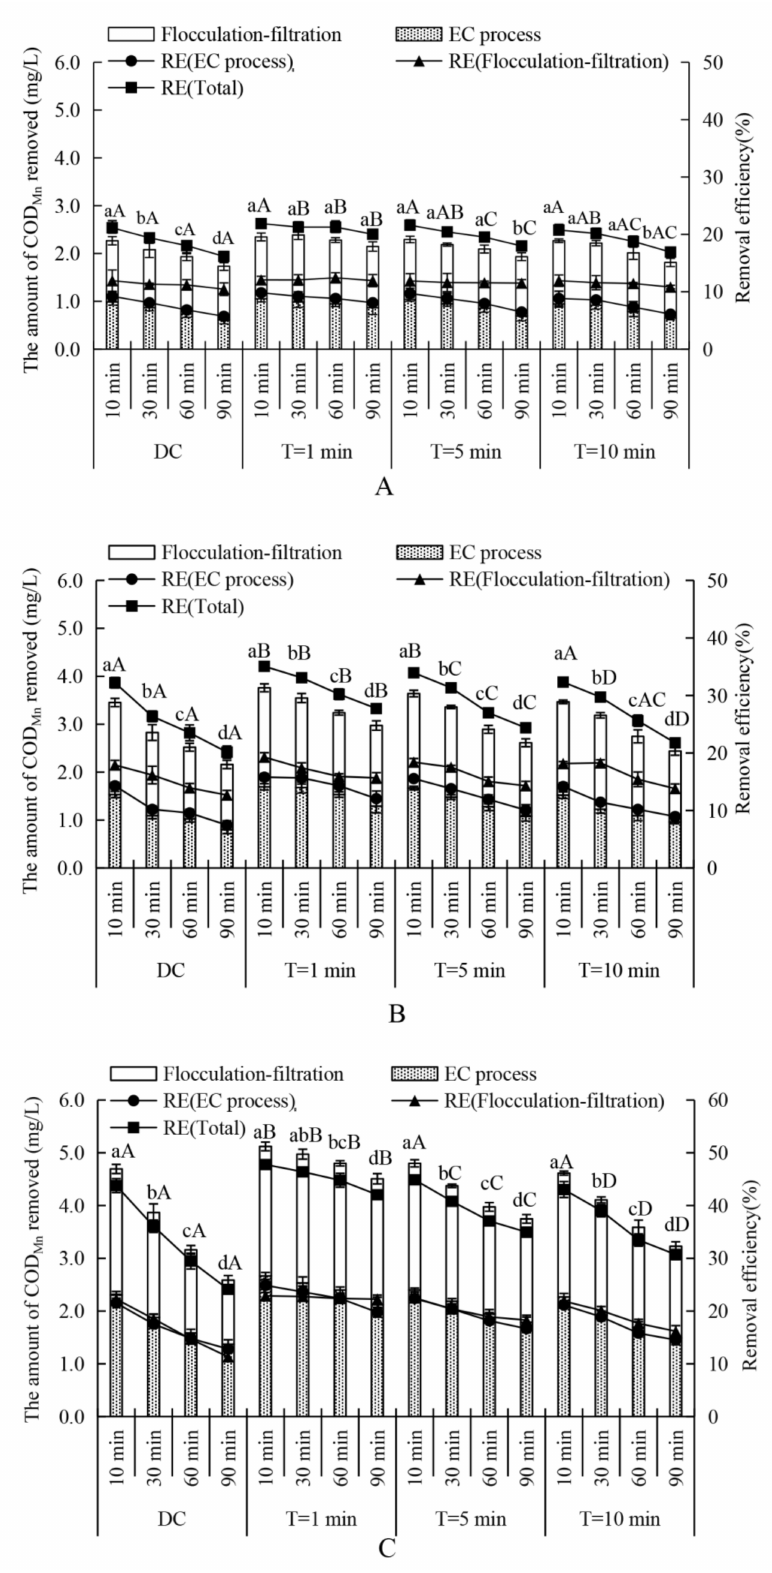
Figure 5. Effects of current density and CCP on the removal of COD Mn by the EC − filtration system: ( A ) j = 15 A/m 2 , ( B ) j = 30 A/m 2 , ( C ) j = 45 A/m 2 . In the same CCP, different lowercase letters on the RE(Total) indicate significant differences ( p < 0.05). At the same operation time across different CCPs, different uppercase letters on the RE(Total) indicate significant differences ( p <